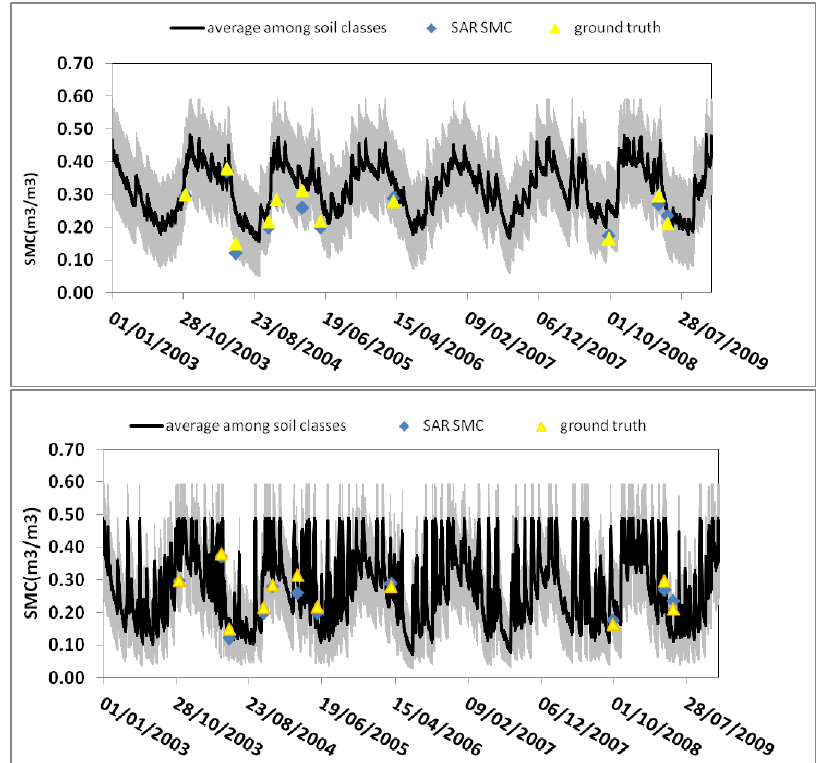
Figure 4. Temporal evolution of SMC (in m 3 /m 3 ) derived from hydrological model (black points), ground truth (triangles) and ANN algorithm (diamonds) samples, for 30 cm-topsoil ( top ) and 5 cm-topsoil ( bottom ) on Scrivia test site. Average and 5%–95% intervals are